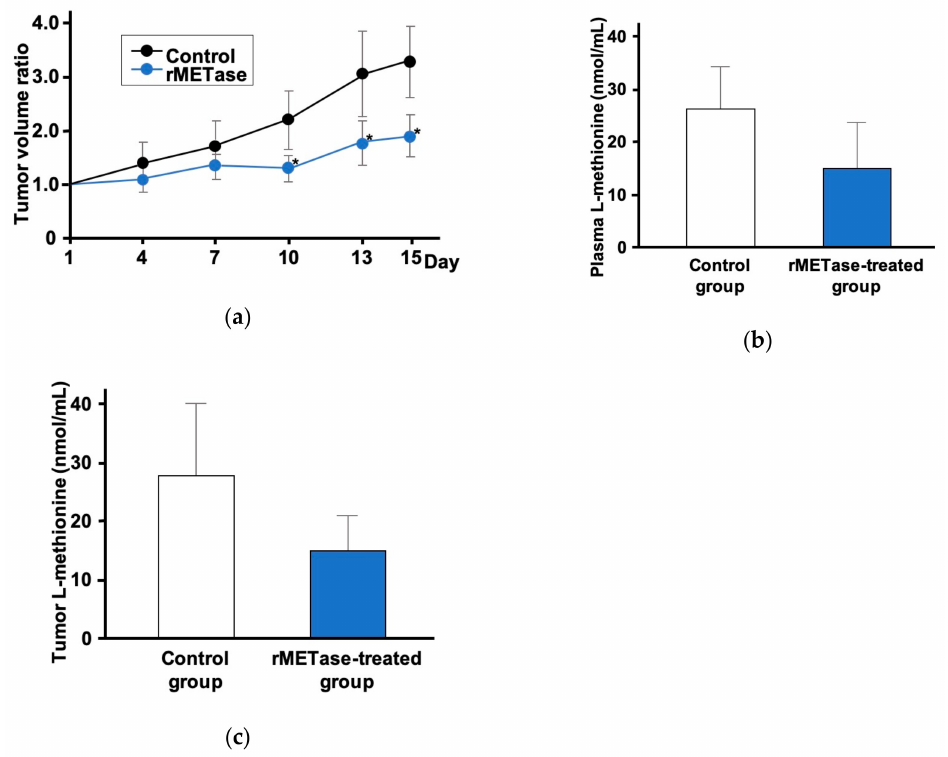
Figure 3. Intraperitoneal (i.p.) recombinant methioninase (i.p.-rMETase) for patient-derived orthotopic xenograft (PDOX). ( a ) Response of Ewing’s sarcoma patient-derived orthotopic xenograft (PDOX) to intraperitoneal injection (i.p.-rMETase). The plasma L-methionine level ( b ) and intra-tumoral L-methionine level ( c ) after i.p.-rMETase treatment. * p = < 0.05, error bars show the standard deviation (SD)